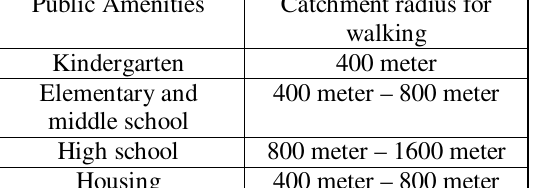
Table 7: Amenities within the range of radius 3 (400m) and radius 4 (800m)